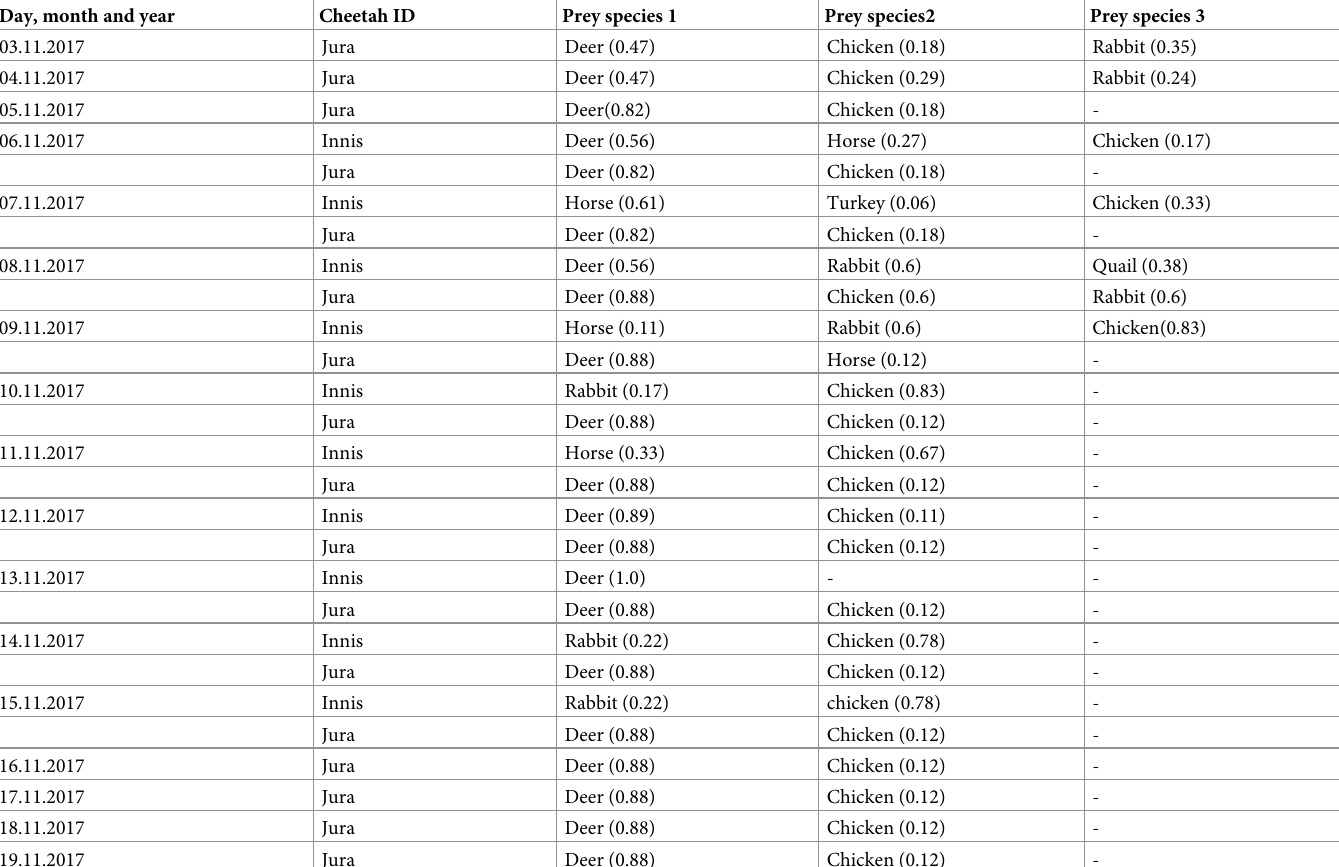
Table 1. List of prey species (and proportions) fed to cheetahs each day during the captive feeding experiment.